Question: What caption would you write for this figure?
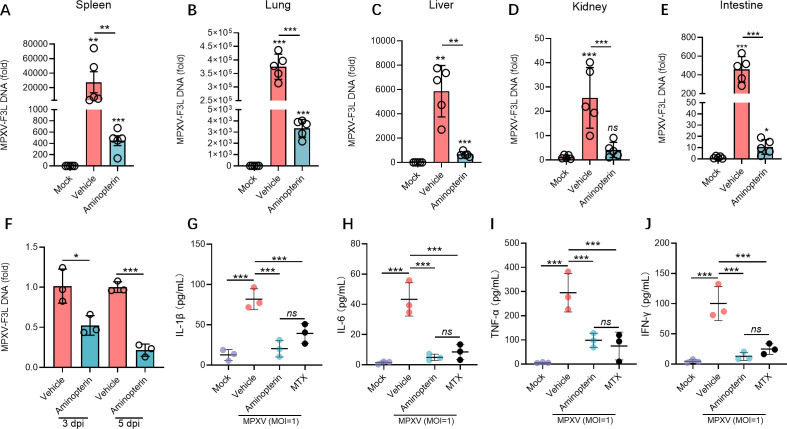
Answer: Aminopterin inhibits systemic MPXV replication and reduces virus-associated inflammatory factors levels in vivo. ( A–E ) The levels of MPXV-F3L DNA in lung, spleen, liver, kidney, and intestine tissues at 8 dpi were detected by qPCR ( n = 5, animals, biological replicates). ( F ) The levels of MPXV-F3L DNA in lung tissues at 3 dpi and 5 dpi were detected by qPCR ( n = 3, animals, biological replicates). ( G–J ) The levels of IL-1β, IL-6, TNF-α, and IFN-γ in the supernatant of MPXV-infected HFF cells were detected by ELISA assay ( n = 3, biological replicates). Data were expressed as means of technical replicates ± SD. One-way analysis of variance ( A–I ) and SNK-q test ( A–I ) were performed in this section (* P < 0.05, ** P < 0.01, and *** P < 0.001, ns : not significant).